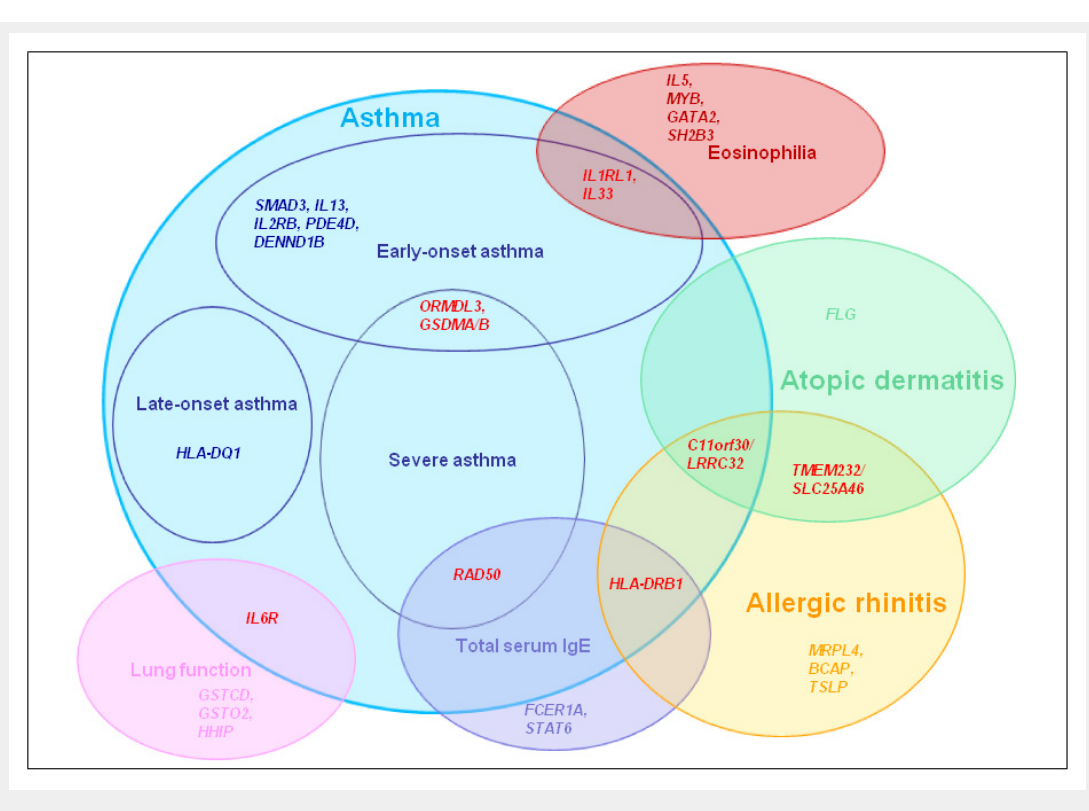
Figure 1 Major susceptibility loci for allergic diseases as identified by GWAS (Venn approach diagram). Genetic loci associated with different subphenotypes are shown in